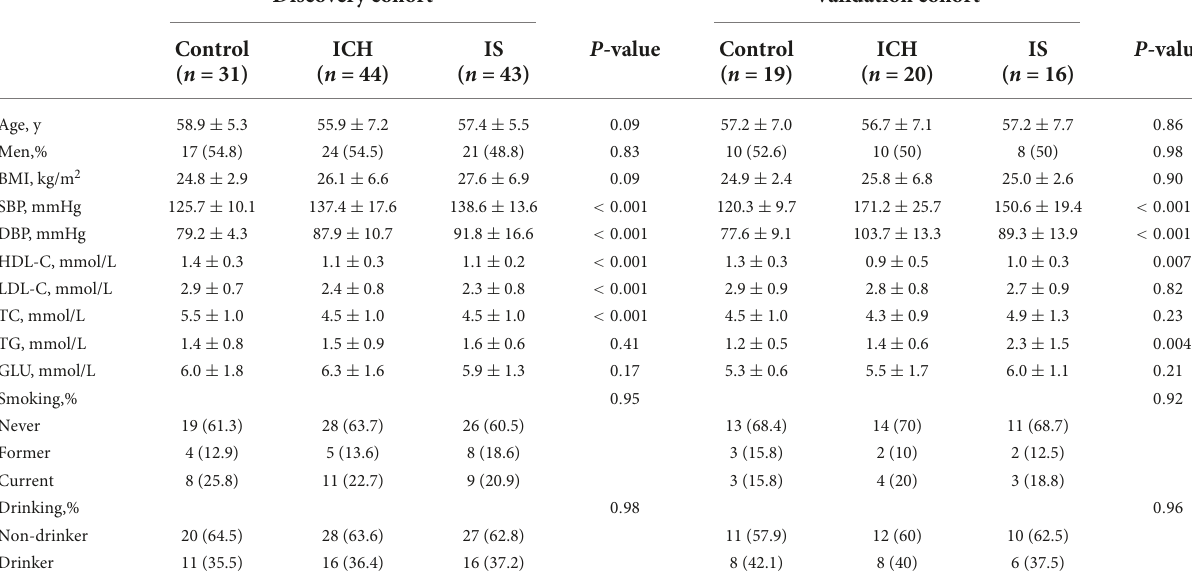
TABLE 1 Demographics and characteristics of the discovery and validation